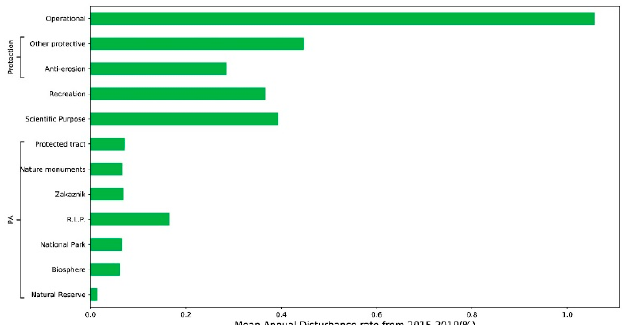
Figure 10. Mean annual rate of old-growth forest disturbance by protection category for 2015-2019.